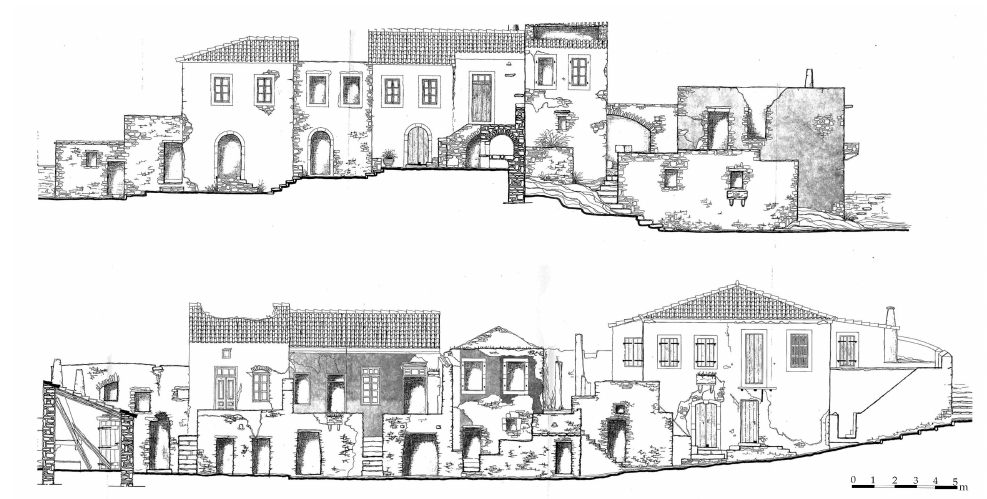
Figure 28. Facades of Mavrogiorgiannika neighborhood based on the drawings of